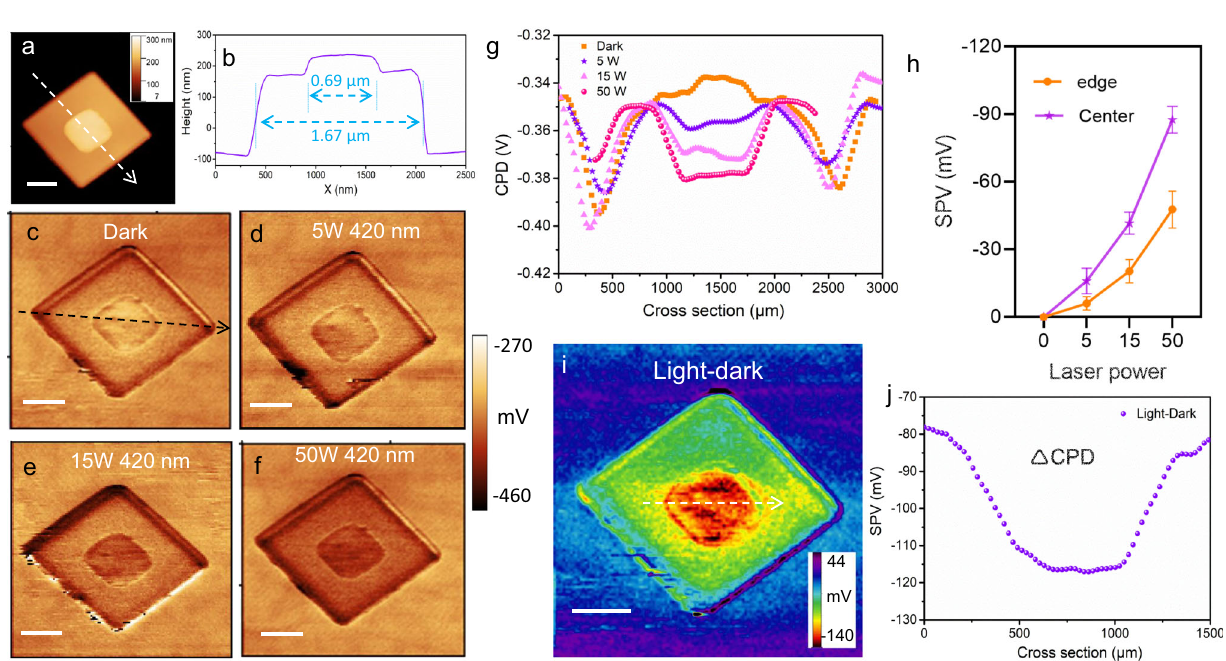
Fig. 5 SPVM analyses of stacked phase-enabled Co-MOF-3 homojunction. a AFM topography image and b the corresponding height pro fi le of Co-MOF- 3. c KPFM image of Co-MOF-3 under no illumination (dark condition). KPFM image of Co-MOF-3 under the irradiation of 420-nm LED light with the power of d 5 W, e 15 W, and f 50 W. g The corresponding normalized CPD pro fi les across the center of Co-MOF-3 (see the arrow line in c ) under the dark and irradiation conditions. h The statistical SPV values ( n = 5, SPV, Δ CPD = CPD light − CPD dark ) collected from the center (purple) and peripheral (orange) regions, respectively, in the (001) facet of Co-MOF-3 stacked nanoplate under the illumination with various power densities (correction of SPV values was done by subtracting the corresponding CPD vaules of the HOPG support). Data are presented as mean values ±S.D. i SPVM image obtained by subtracting the potential under the dark condition from that under 50-W illumination and j the corresponding SPV pro fi Supplementary Fig. 55, the total ion chromatographic peaks at ca. 6.0 and ca. 15.8 min can be assigned to the CO (inset of Supplementary Fig. 55) and CO 2 , respectively. The mass